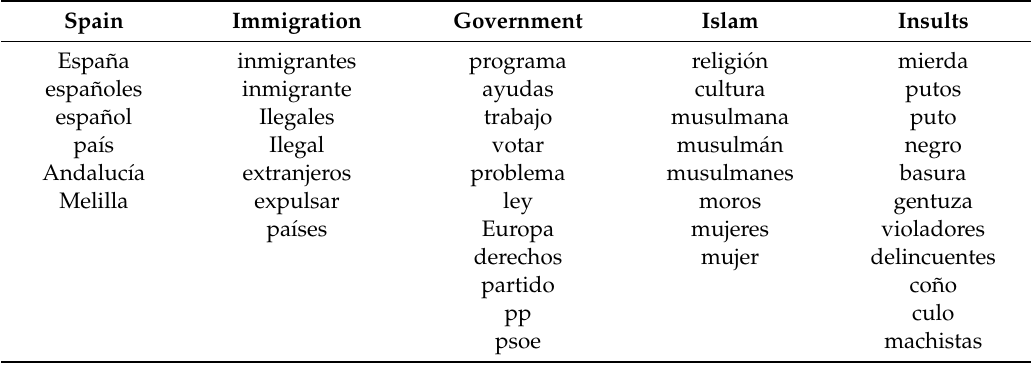
Table 1. Manual grouping of the terms by